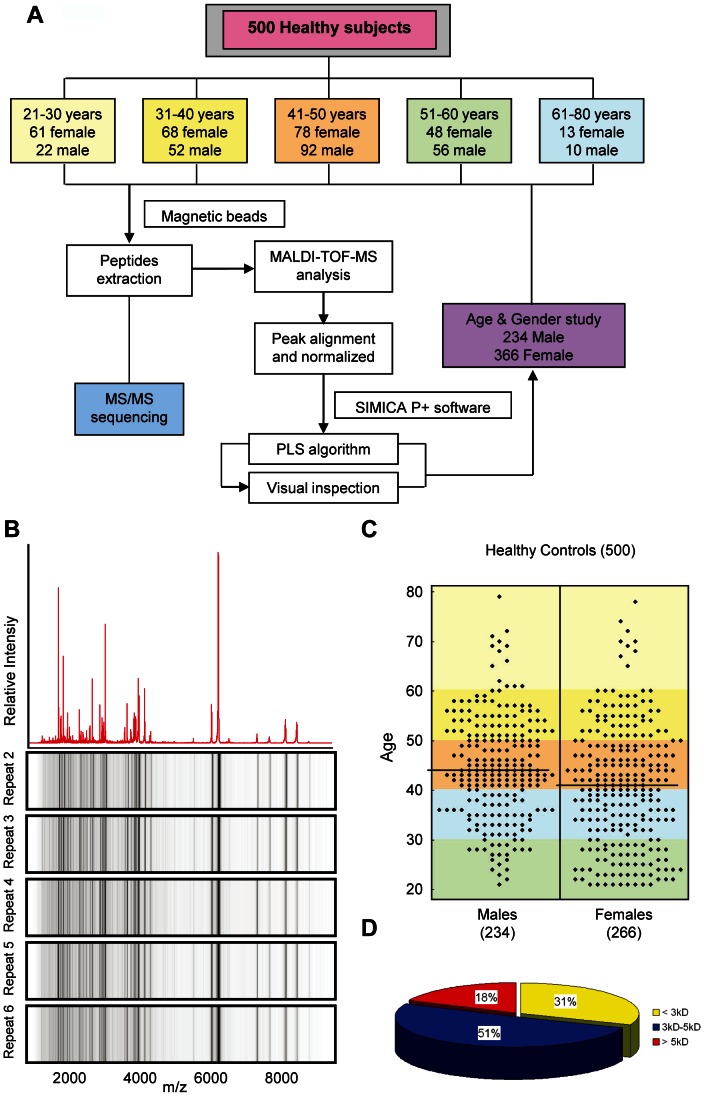
Peptide profiles in healthy subjects.(A) Study overview. The diagram shows the design of the healthy serum peptidome demographic study, and the statistical analysis approach used for gender and different age groups. (B) Example of within-run reproducibility of mass spectra. Serum from a pooled healthy sample (10 individuals) was prepared with copper-chelated magnetic bead extraction. Six in one day randomly selected spectra obtained by MALDI-TOF MS and pseudo gel spectra used in the analysis. The analysis m/z range is from 1 KD to 10 KD. (C) Age distribution of 500 healthy subjects. The colored fields indicate the five age groups used throughout this study. The black horizontal lines represent medians for each cohort. (D) Distribution of 65 peptides with their molecular weight ranges.